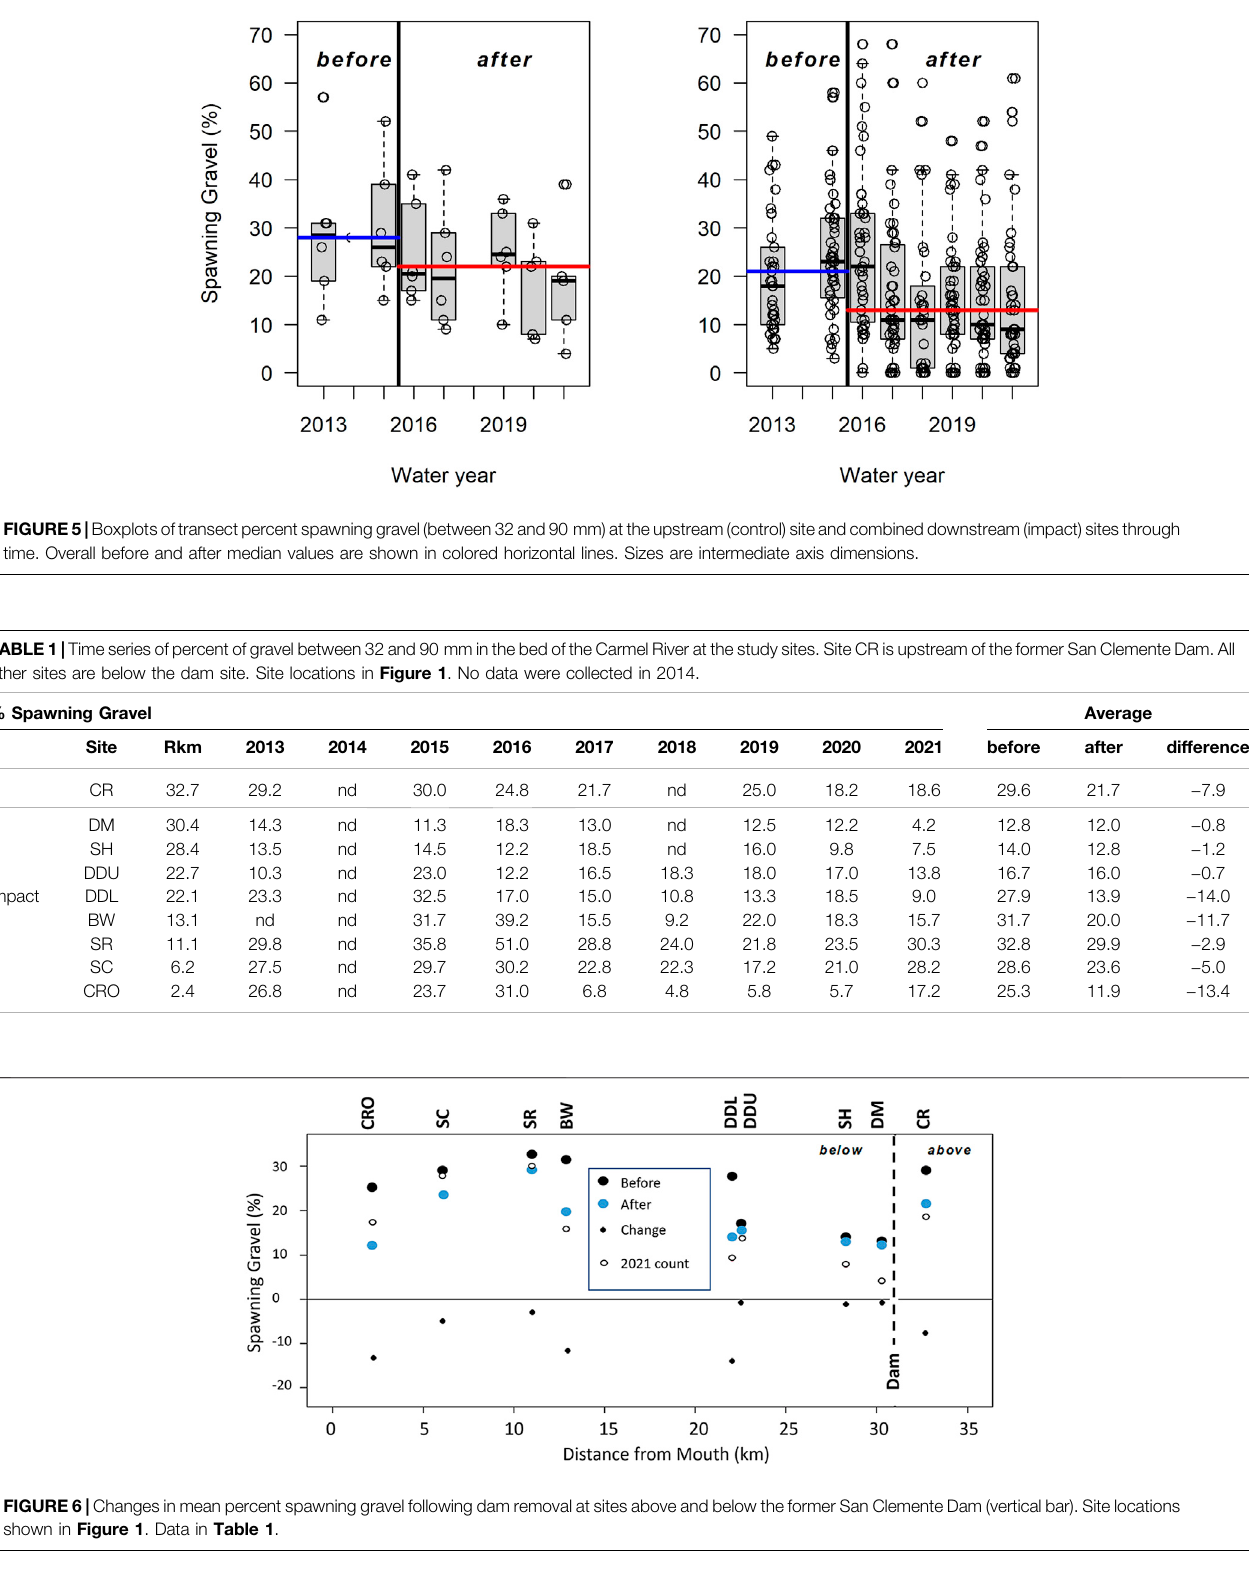
Frontiers in Earth Science |